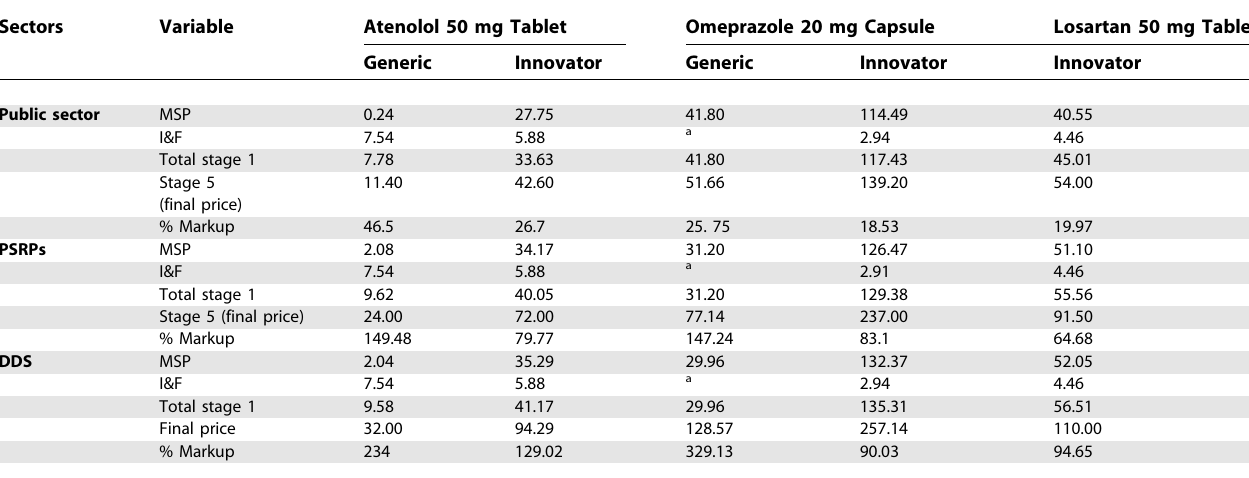
Table 5. Summary and Markups for Different Drugs in Public Sector, PSRPs, and DDS